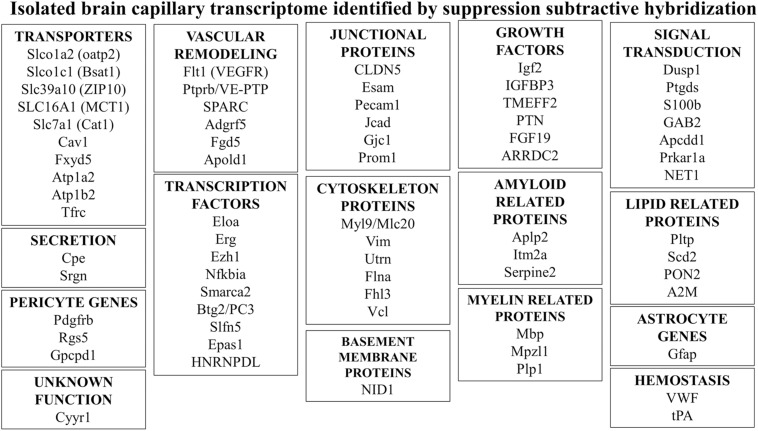
Genes of common function were identified by suppression subtractive hybridization following isolation of RNA isolated from microvessels obtained from either fresh rat brain or fresh human brain removed at neurosurgery (Li et al., 2001a, 2002; Shusta et al., 2002a). Additional details for all genes shown are given in Supplementary Table 1.